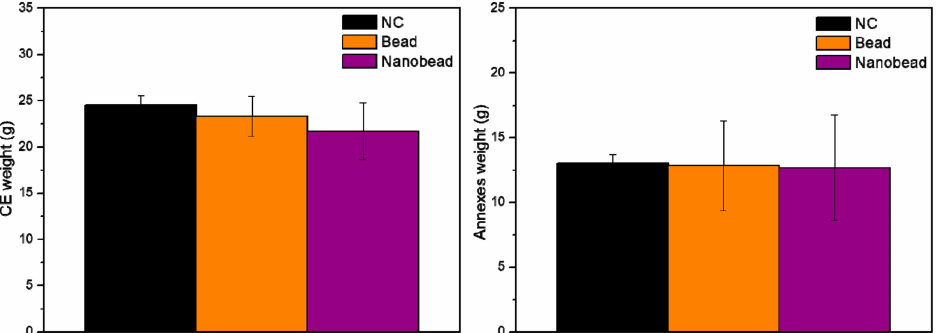
Figure 10. The weight (g) of chicken embryo (CE) and annexes after 48 h of treatments with 0.9% NaCl solution (NC), xanthan-coated bead loading indomethacin (bead) (XAN@CHT/INDO; 20 mg/egg) and xanthan-coated nanobead (nanobead) (XAN@CHT/NLC-INDO; 20 mg/egg). Data are expressed as mean ± SEM, n = 12. One-way ANOVA/Tukey tests were carried out for intergroup statistically differences analyses ( p < 0.05). INDO treatment was not considered once there was no survivors after 48